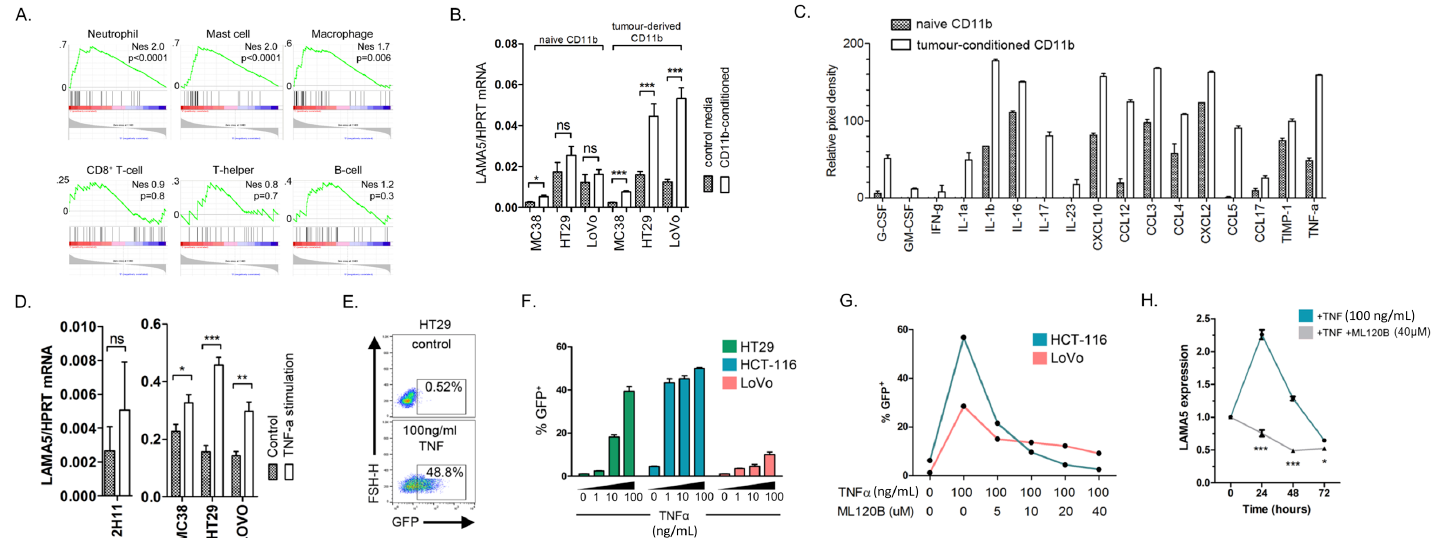
Figure 3. Laminin 511 expression is promoted by myeloid cell activity. ( A ) GSEA for enrichment of gene signatures reported to define specific immune cell infiltrates (immunomes) in TCGA colon cancers over-expressing LAMA5, LAMB1 and LAMC1. ( B ) Immunofluorescence staining for LAMA5 in HT29 liver metastases from control mice (top) and those treated with anti-Ly6G (1A8), an antibody that depletes neutrophils (lower). Scale bar represents 20 μ m. ( C ) Quantification of the percentage of the liver metastatic area staining positive for LAMA5 in HT29 or HCT116 tumour-bearing control mice (green), or those depleted of neutrophils (pink). A minimum of five mice per group were included with at least three tumour areas quantified per mouse. ( D ) LAMA5 expression in cultured murine and human colon cancer cells after 24 h of culture in naïve or liver metastasis-derived CD11b + myeloid cell-conditioned media. Error bars generated from biological triplicates. ( E ) Semi-quantitative analysis of the concentration of various cytokine proteins in the conditioned media from naïve (grey) or liver metastasis-derived (clear) CD11b + myeloid cells determined using a commercially available antibody-based protein array. Error bars generated from biological triplicates. ( F ) LAMA5 expression in cultured murine and human colon cancer cells or the murine endothelial cell line 2H11, 24 h after stimulation with PBS (grey) or 100 ng/mL TNF α (clear). Error bars generated from biological triplicates. ( G ) Flow cytometry of NF κ B-GFP reporter HT29 cells 24 h following treatment with PBS (top) or 100 ng/mL TNF α (below) demonstrating an increase in GFP expression in the later. ( H ) Percentage GFP + HT29, HCT116 or LoVo cells 24 h following treatment with increasing concentrations of TNF α to a maximum concentration of 100 ng/mL. Error bars generated from biological triplicates. ( I ) Percentage GFP + HCT116 or LoVo cells 24 h following treatment with TNF α and/or the NF κ B inhibitor ML120B as indicated. ( J ) LAMA5 expression in HCT116 cells treated with 100 ng/mL TNF α with (grey) or without (green) 40 μ m ML120B. Error bars generated from biological triplicates. Student’s t -test throughout. p < 0.05 considered significant. * 0.01 < p ≤ 0.05, ** 0.001 < p ≤ 0.01, *** p ≤ 0.001, ns: not significant.